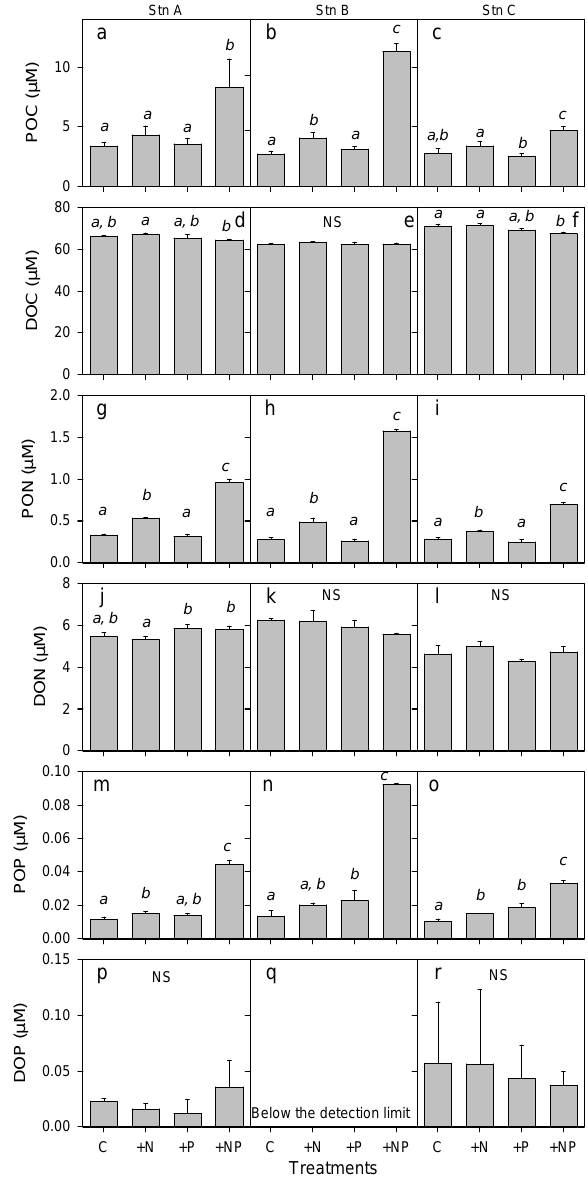
Fig. 3. Comparison of responses of concentration (µM) of POC ( a, b, c ) DOC ( d, e, f ), PON ( g, h, i ), DON ( j, k, l ), POP ( m, n, o ), and DOP ( p, q, r ) between the different treatments at the last day of the experiment. Values are shown as mean ± SD. C, +N, +P, and +NP denote Control, NH 4 addition, PO 4 addition, NH 4 +PO 4 ad- dition, respectively. Columns labeled by different italic letters ( a or b ) are significantly different at P < 0 . 05. NS denotes no significant effect of different nutrient treatments on the parameter measured. See Materials and methods for